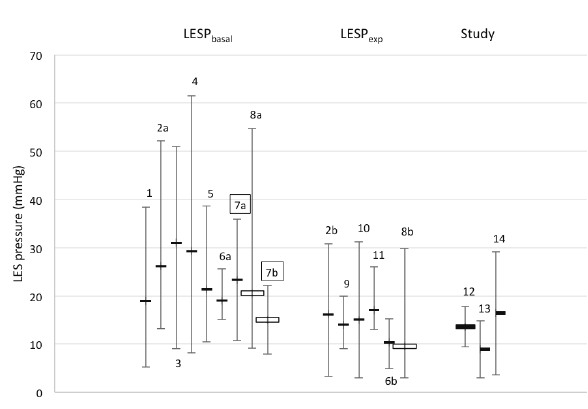
Figure 3: LES resting pressure LESP – basal LES pressure basal LESP – end-expiratory LES pressure, Study – LES pressure in exp present study Markers: black thin bars – solid-state; framed white bars – water- perfusion; black thick bars – gas-perfusion Statistics: Median and 5th-95th percentile – 1-5, 8, 10; Median and interquartile range – 6, 9, 11; Mean and SD – 7,